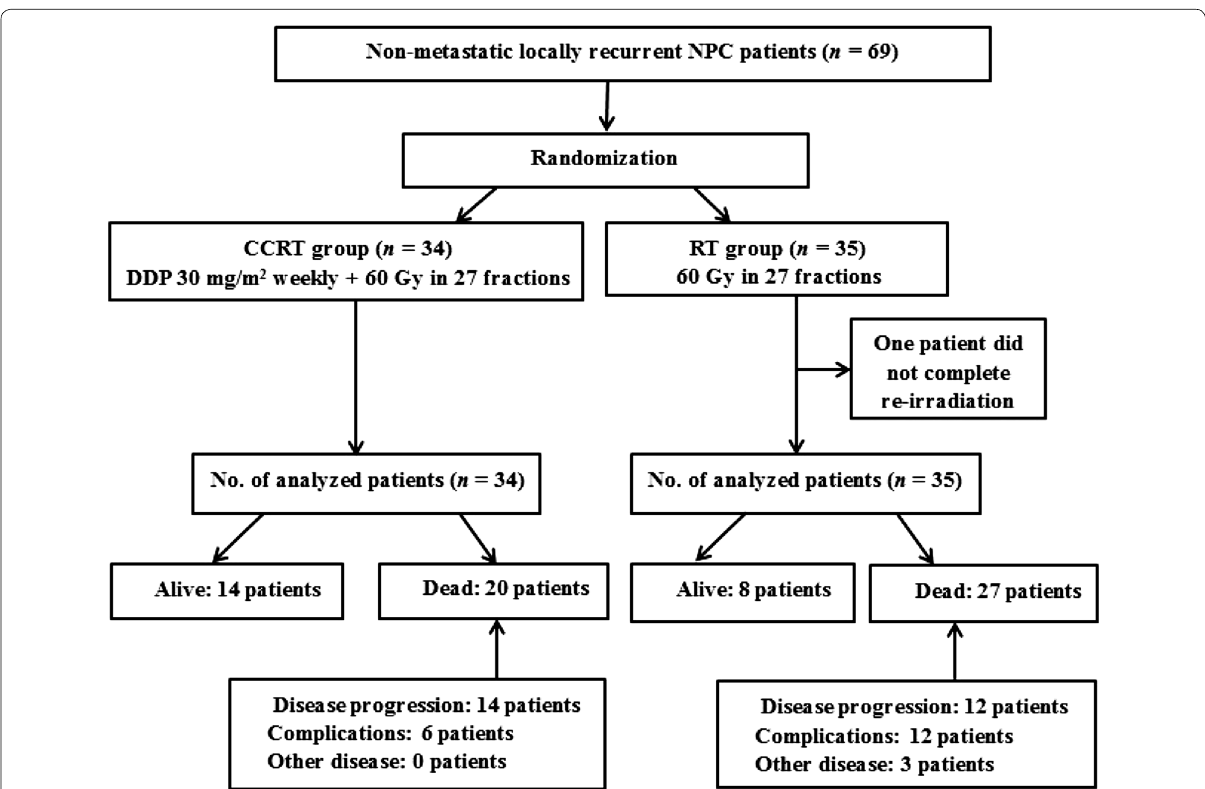
Fig. 1 Flowchart for trial participants of the study. NPC nasopharyngeal carcinoma, CCRT concomitant radiochemotherapy, RT radiotherapy alone, DDP cisplatin, No.